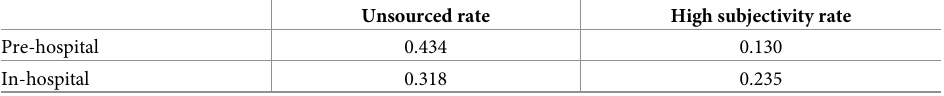
Table 6. Rate of unsourced and high subjectivity segments in two sections. The sections “Pre-hospital” and “In-hos- pital” include descriptions of patients before and after